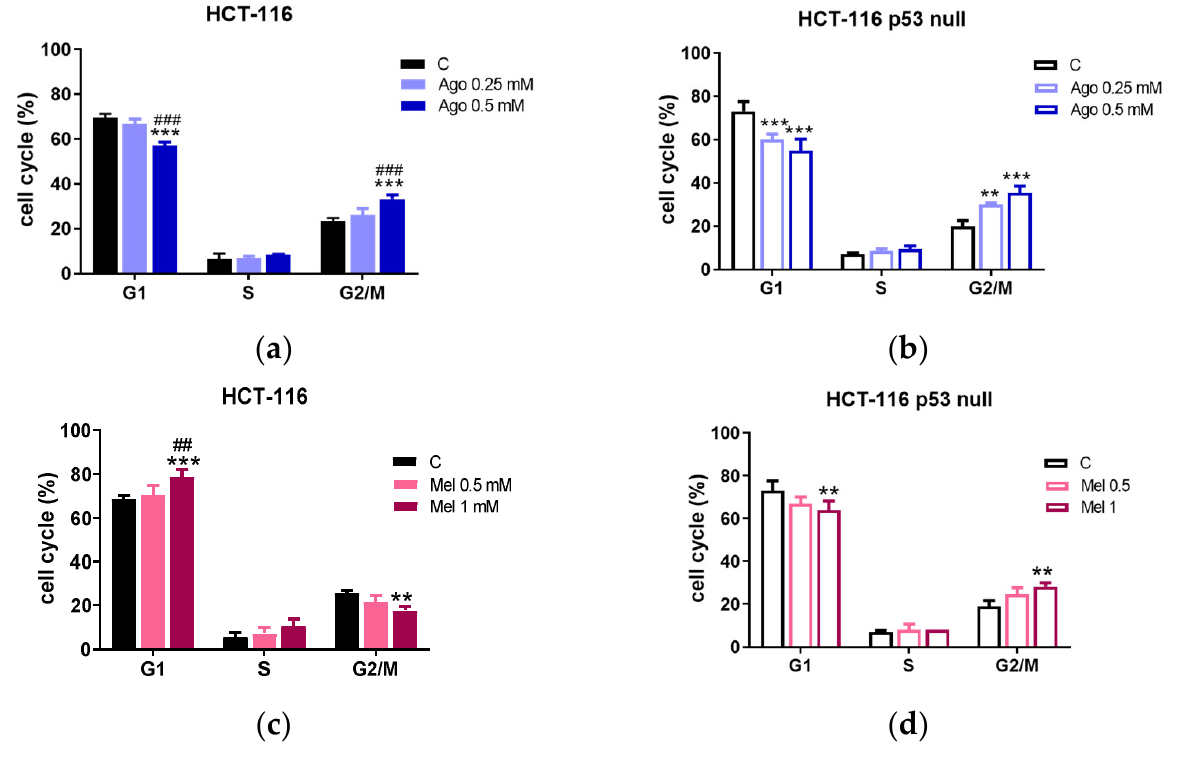
Figure 2. Percentage distribution in the different stages of the cell-cycle after treatment of HCT-116 and HCT-116-p53-null cells with agomelatine (Ago) ( a , b ) and melatonin (Mel) ( c , d ). Data represent the mean ± SD of three experiments performed in triplicate. ** Values of p < 0.01 vs. C; *** p < 0.001 vs. C. ## p < 0.01 vs. lower doses of treatment; ### p < 0.001 vs. lower doses of treatment. The treatment with 1 mM melatonin for 72 h induced accumulation in the G1 phase of the cycle in the HCT-116 (78.70 ± 3.33% of melatonin-treated cells versus 68.5 ±